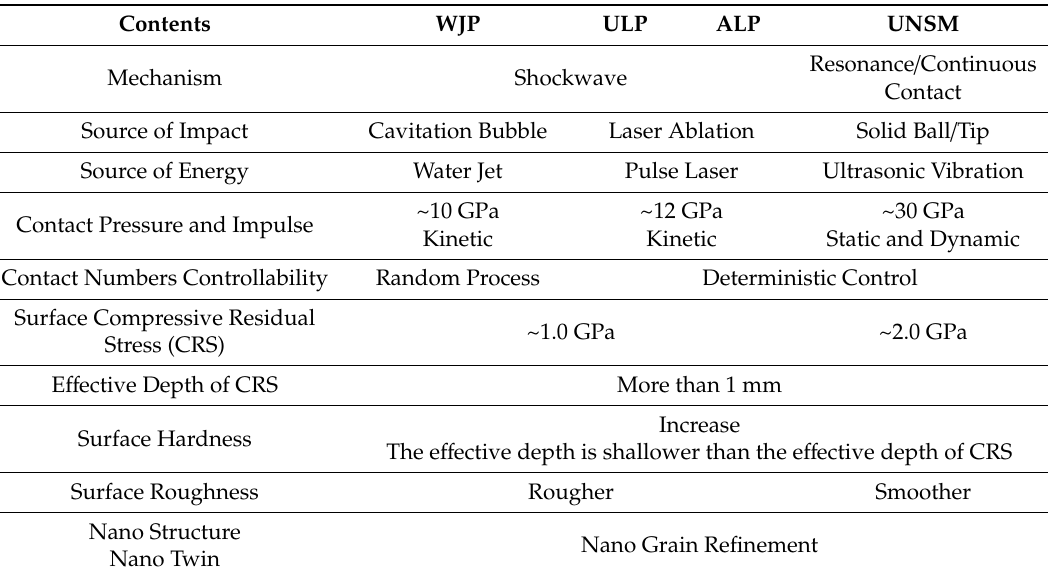
Table 2. Comparison of the four advanced surface modification process.